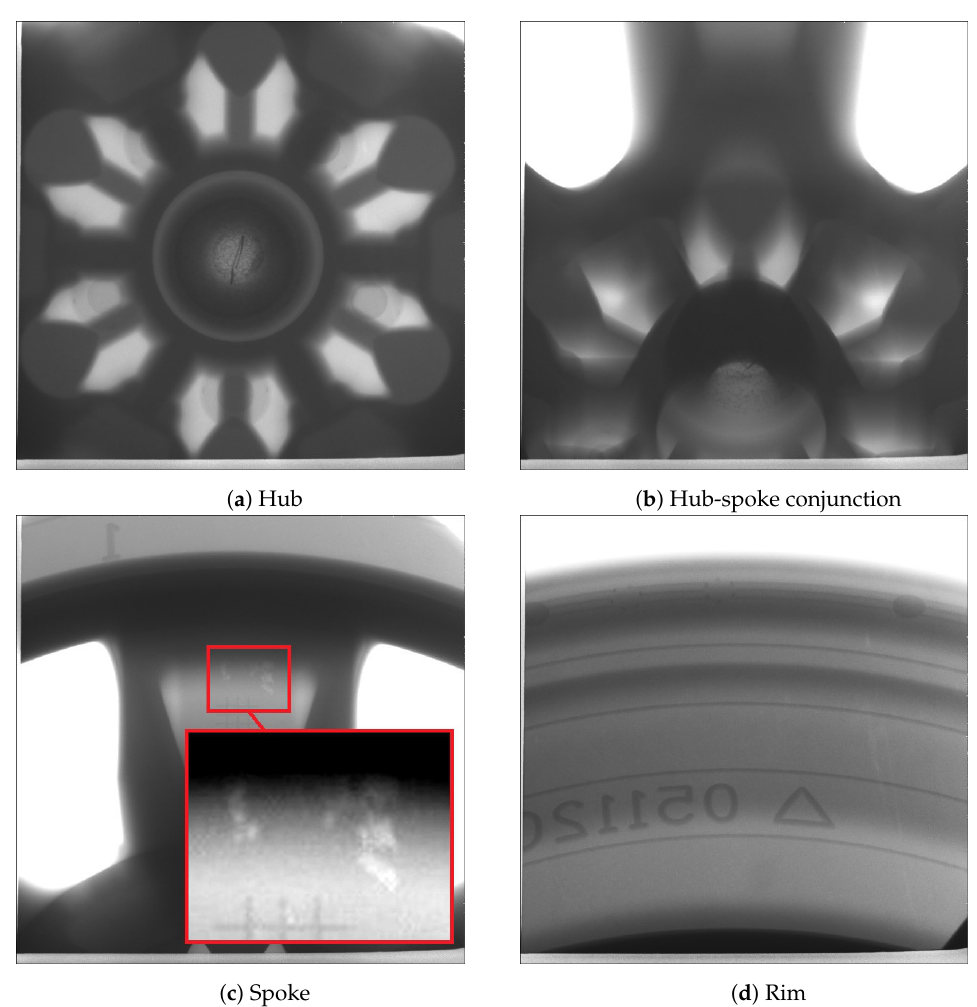
Figure 16. X-ray images of the wheel selected from the non-production (porosity) process condition. For a given die structure, tuning the water and/or air cooling parameters is the most common approach to controlling the die temperature evolution and therefore solidification in industry. In the two process conditions, the cooling parameters were set to be different (other parameters were identical). The production conditions were carefully tuned to achieve directional solidification within the wheel, to avoid producing areas of liquid encapsulation, whereas the non-production conditions were aimed at forming an area of liquid encapsulation in the vicinity of the rim/spoke junction. The cooling parameters for both process conditions are plotted in Figure 17 for easy comparison. This was done to produce a comprehensive set of process data suitable for testing the LPDC process model’s ability to predict the evolution of temperature in the die and wheel for a set of process conditions different from those used to “tune” the model boundary conditions and to also assess the ability of the model to predict areas of liquid encapsulation and associated porosity. The model development and comparison to the process data are presented in Part II of this